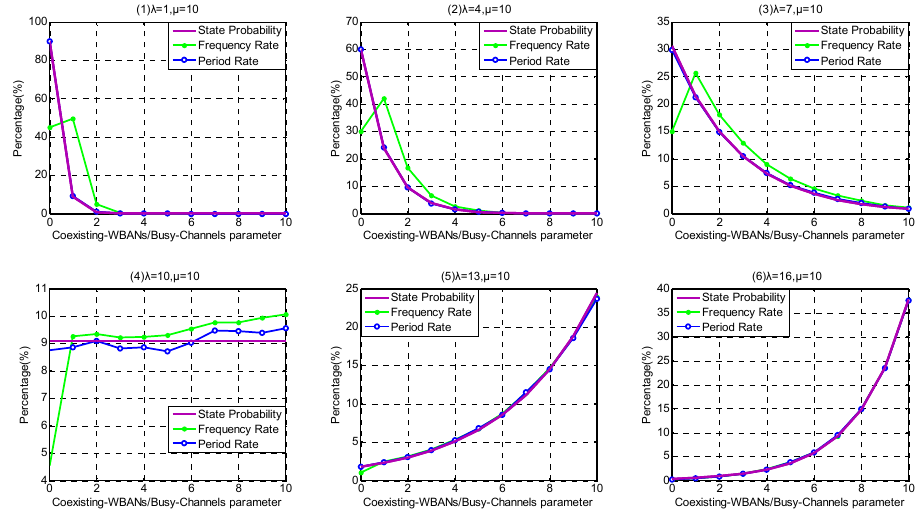
Figure 11. Coexisting-WBAN/Busy-channel Parameter probability distribution under 1-tolerated channel conflict model in Service-dependent coexisting